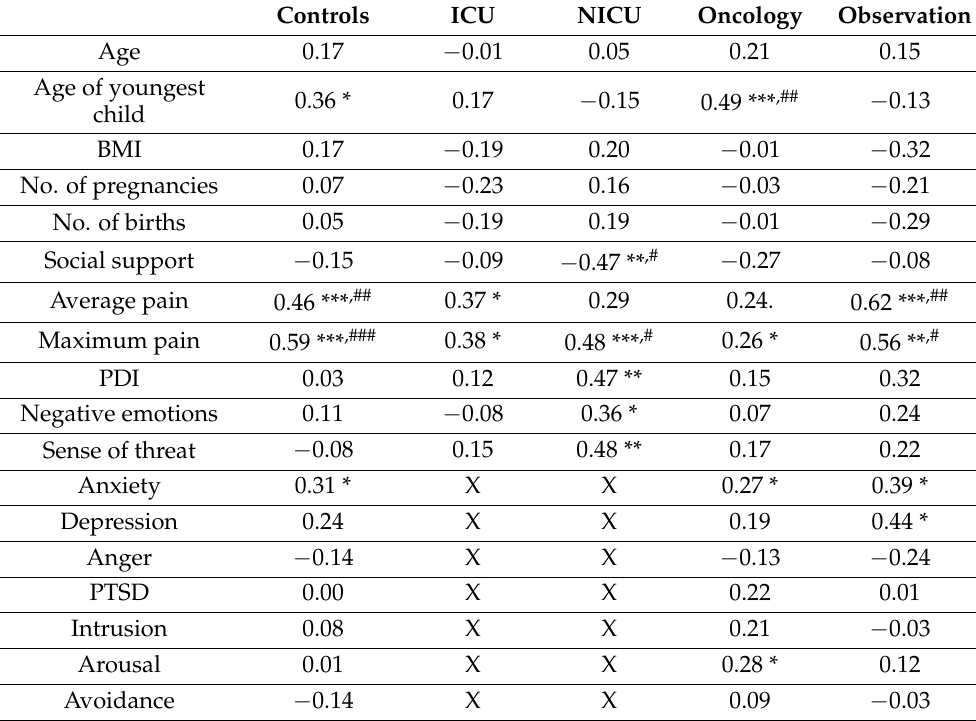
Table 6. Correlations between SRH and selected demographic, medical, and psychological variables (Spearman’s rho).